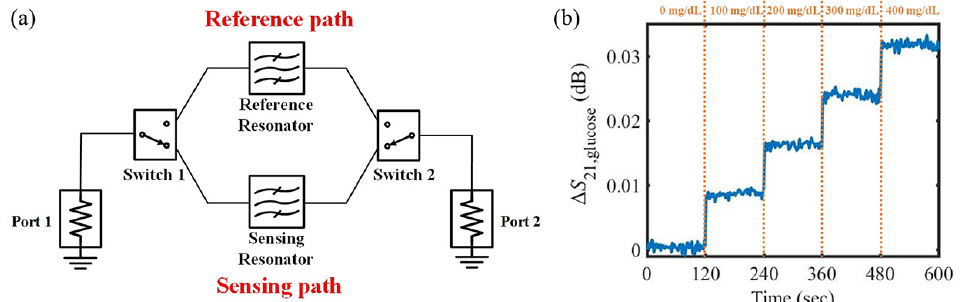
Figure 13. Glucose concentration detection using dual complementary split-ring resonators with a switching circuit for environmental effect elimination. ( a ) Schematic of the glucose sensor. ( b ) Vari- ation in the transmission coefficient of the sensor as a function of the glucose concentration after environmental effect elimination. (Reprinted with permission from [104]; published by IEEE,